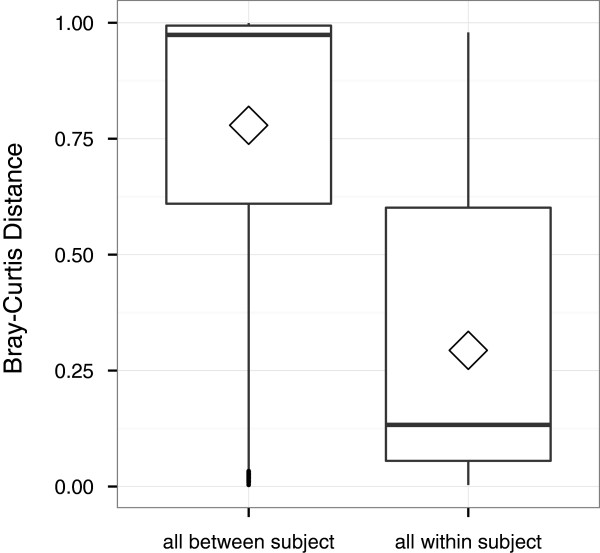
Average Bray-Curtis ecologic distance from jackknifed distance matrices of vaginal microbiomes. The horizontal lines indicate the median distances; boxes indicate the interquartile ranges; whiskers extend to 1.5 times the interquartile range; and the diamonds indicate means.